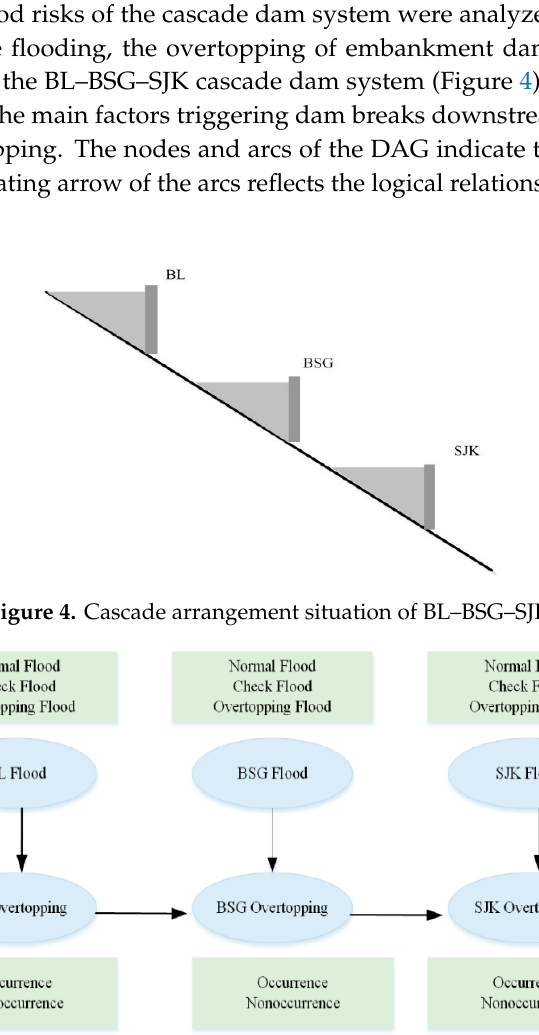
Figure 5. The simple mode of connection reservoirs based on the Bayesian network (BN) model.